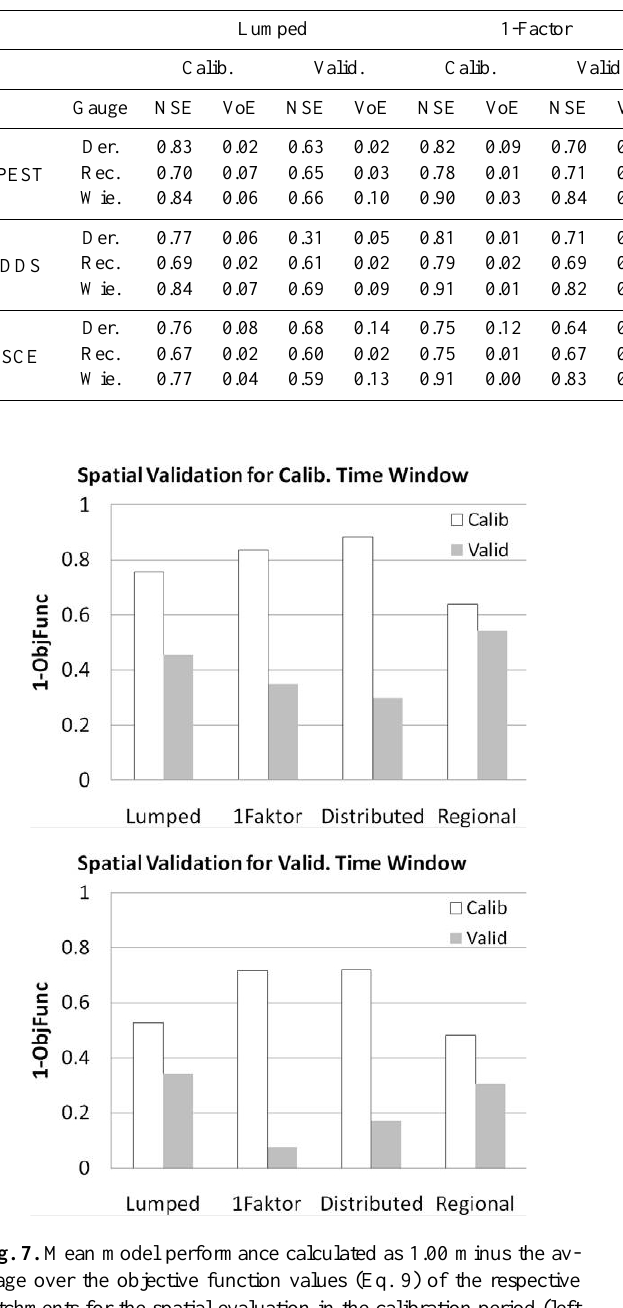
Table 2. Nash-Sutcliff efficiency and volume error for the calibration and validation of the different catchments and the different optimisation algorithms (gauges: Der. = Derneburg; Rec. = Reckershausen; Wie. = Wieckenberg). The calibration years are 2004, 2007 and 2008. The validation was done for 2005 and 2006.